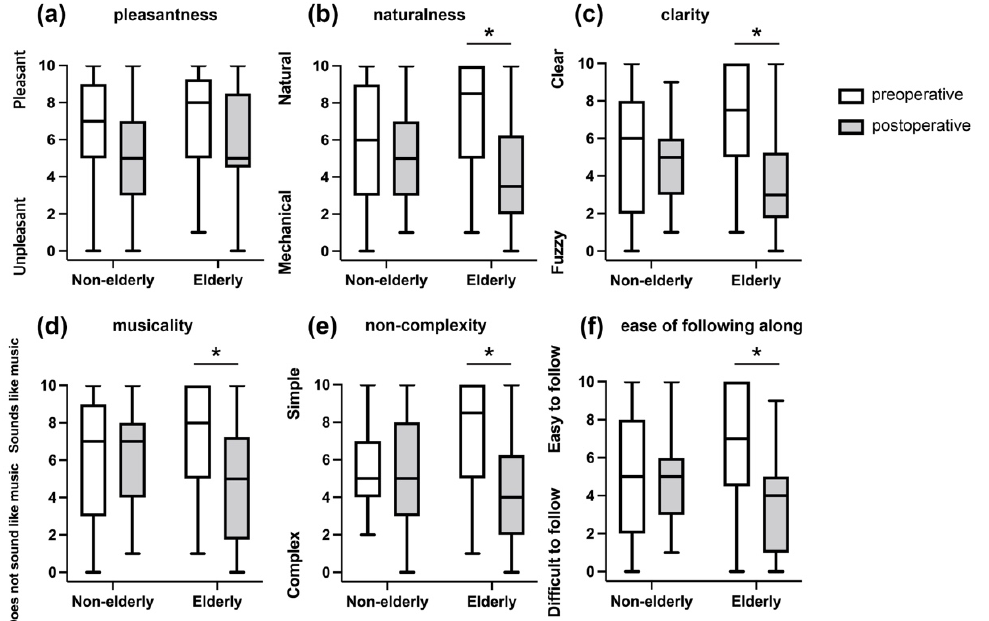
Figure 1. Comparison of perceived music quality between the non-elderly group and the elderly group before and after receiving a cochlear implant. ( a ) Pleasantness; ( b ) naturalness; ( c ) clarity; ( d ) musicality; ( e ) non-complexity; ( f ) ease of following along. The elderly group exhibits significant decreases in the postoperative scores for naturalness, clarity, similarity of sounds to music, non- complexity, and ease of following along compared with their preoperative scores. No significant change is observed for any score in the non-elderly group. * p < 0.05.